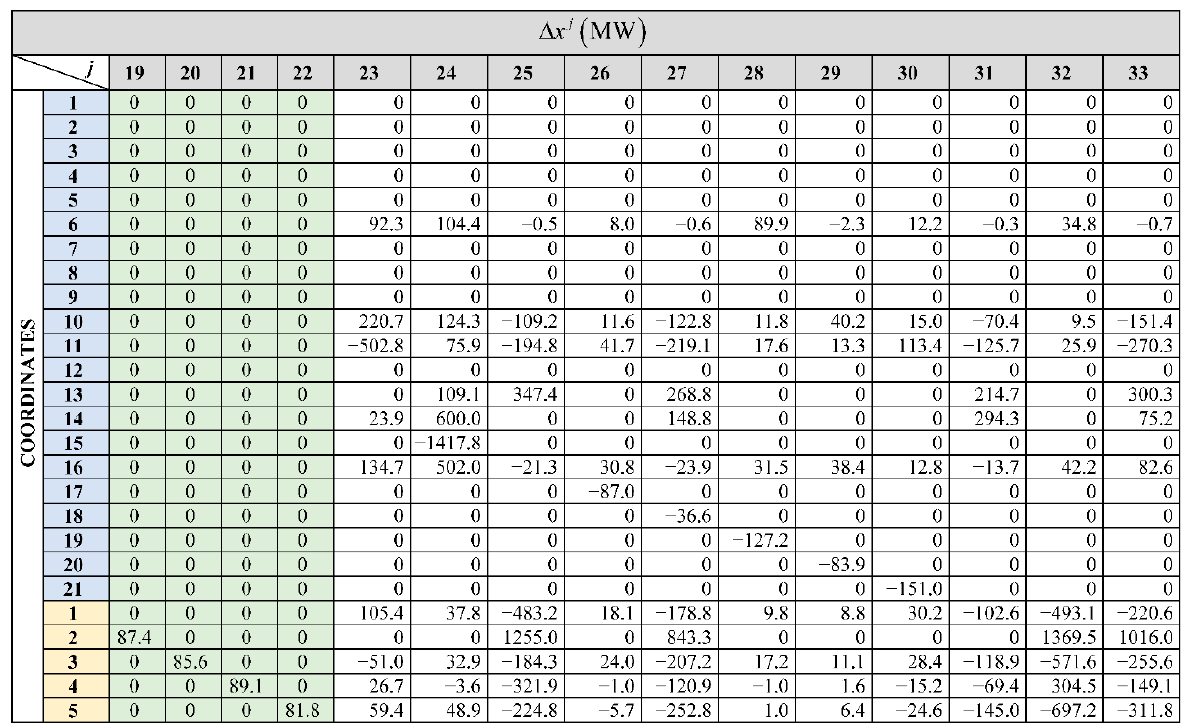
Figure 12. Vectors describing the possible increase and decrease in regional capacities for which the sum of squared errors increases no more than 1%.